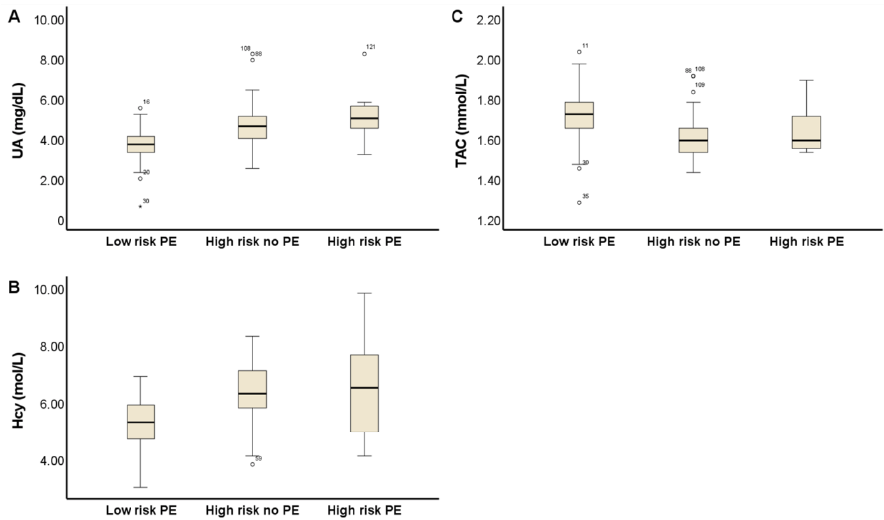
Figure 1. Box and whisker plots showing plasma levels of oxidative stress biomarkers in the study groups. AU, Uric acid ( A ); Hcy, Homocysteine ( B ); and TAC, Total antioxidant capacity ( C ). The results of the measurement of inflammatory and endothelial dysfunction